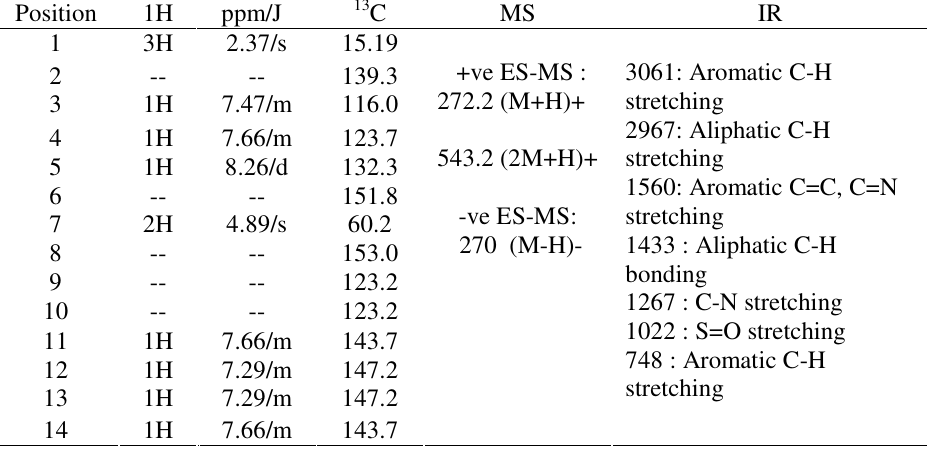
Table 1. 1 H and 13 C NMR, MS and IR assignments for des-(trifluoroethoxy)